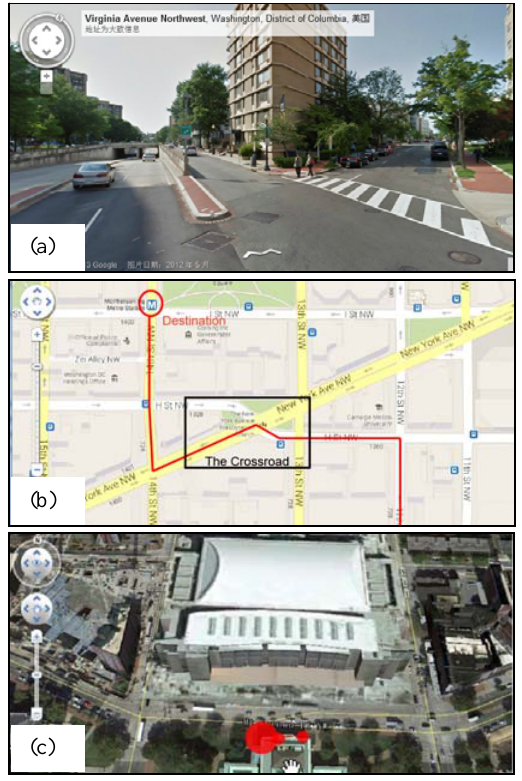
Figure 1. Test interface used in the experiment. (a) Google Street View. (b) Google Map of the experiment area. The red line indicates the planned route. The black box indicates a complicated intersection. (c) Google Earth of the experiment